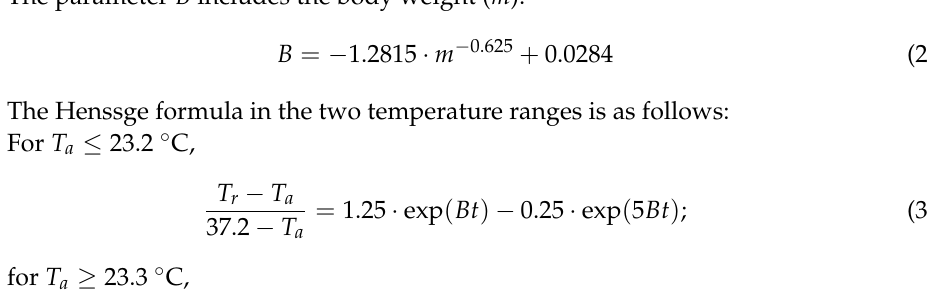
Table 1. The value of the parameter A . T a A ≤ 23.2 ◦ C 1.25